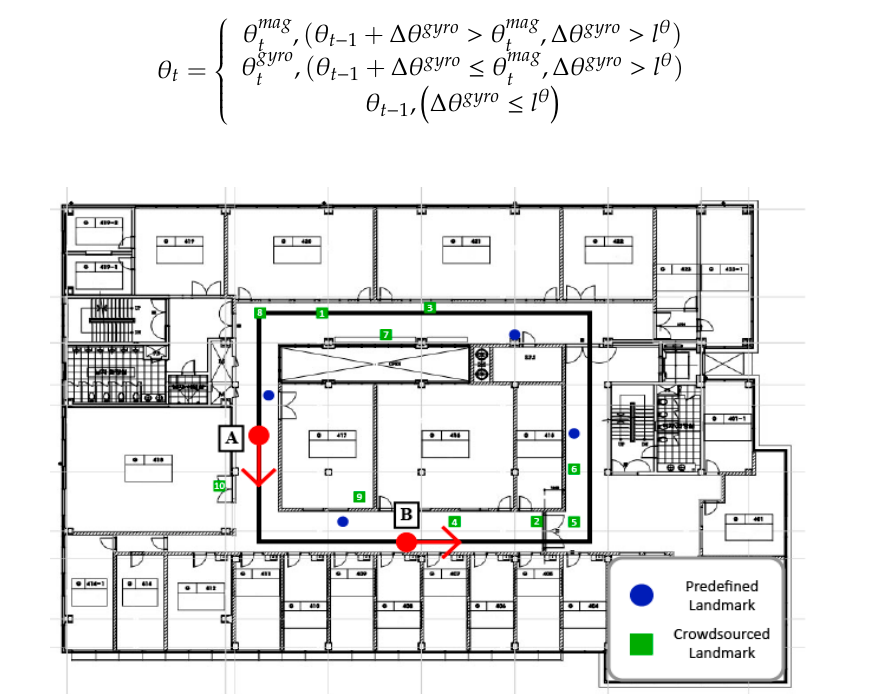
Figure 3. Indoor layout of testbed building with ground-truth reference path.